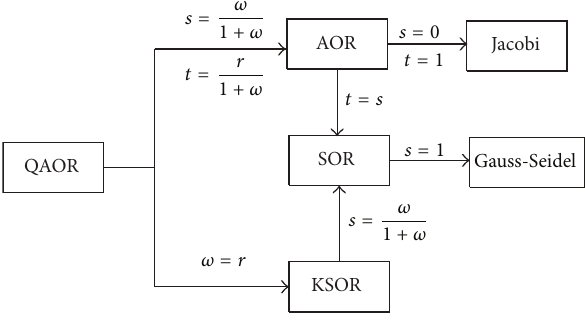
Figure 1: A graph for QAOR and